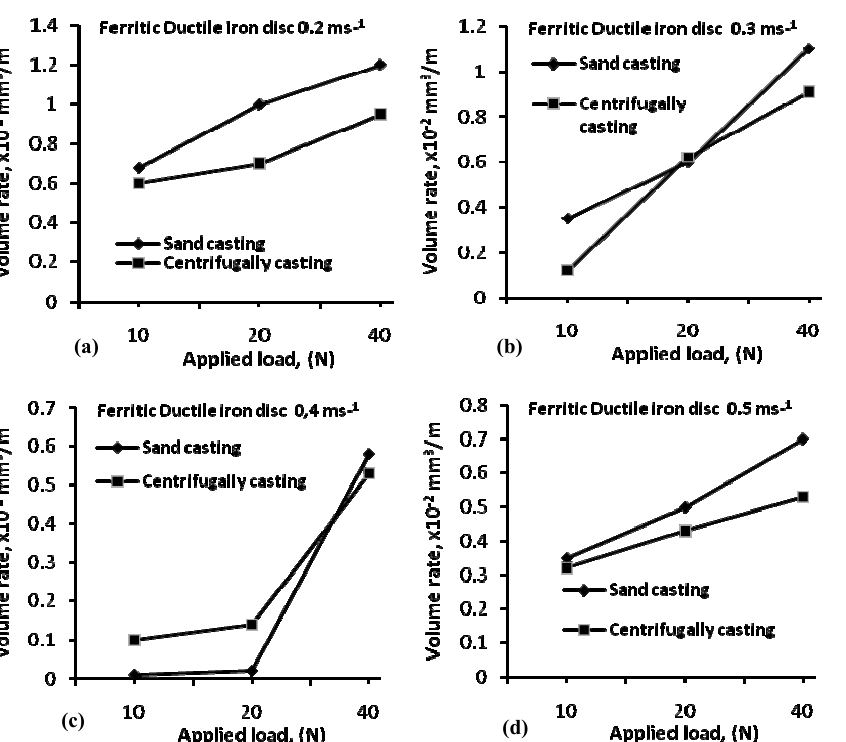
Figure 5. Variation of volume rate vs. applied loads at constant sliding distance (600 m) and different sliding